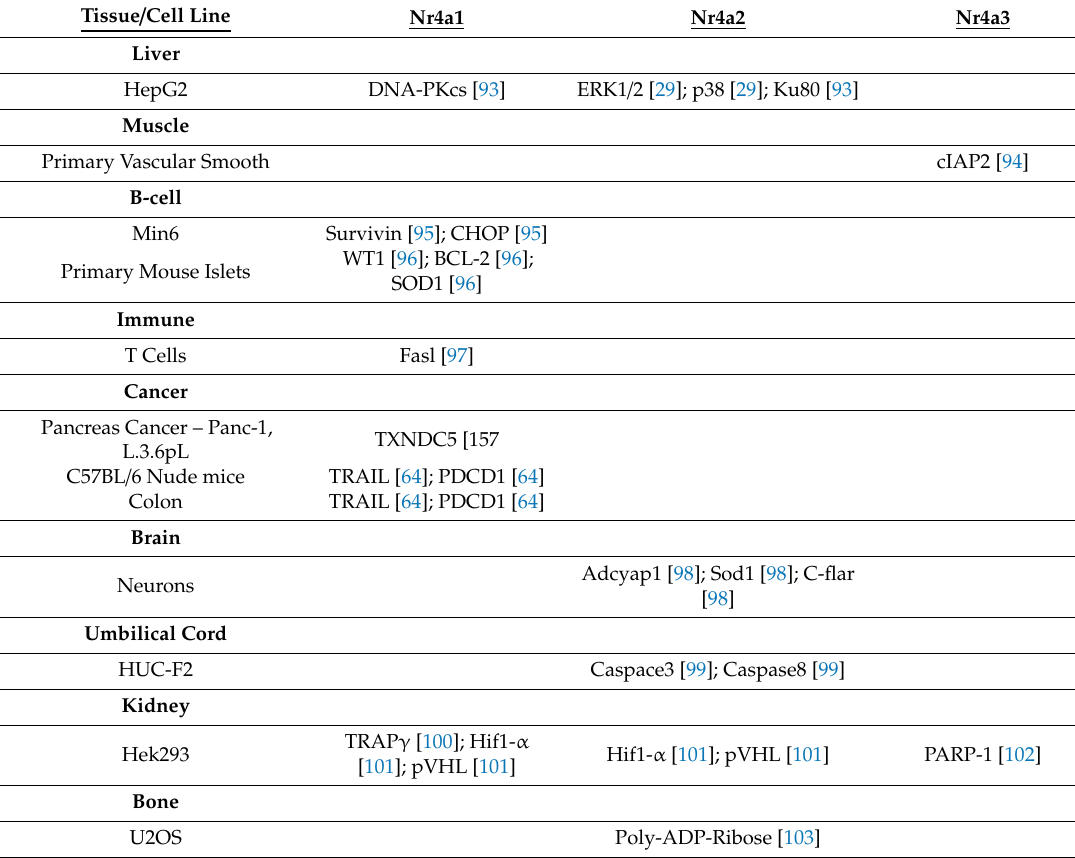
Table 2. Genes regulated by the Nr4a’s that are associated with cellular apoptosis, defined by tissue of interest. References are given for each